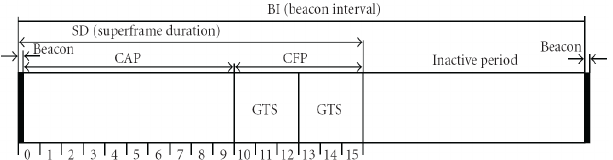
Figure 1. Frame structure of the beacon signal